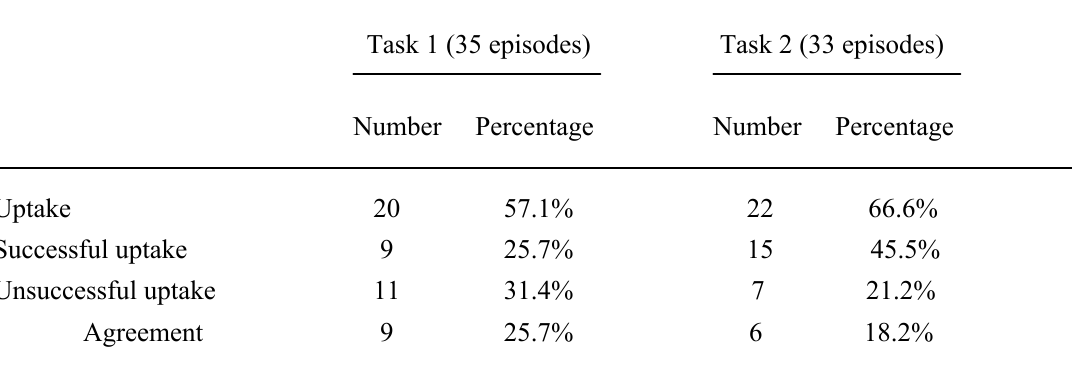
Relation between learners’ uptake and